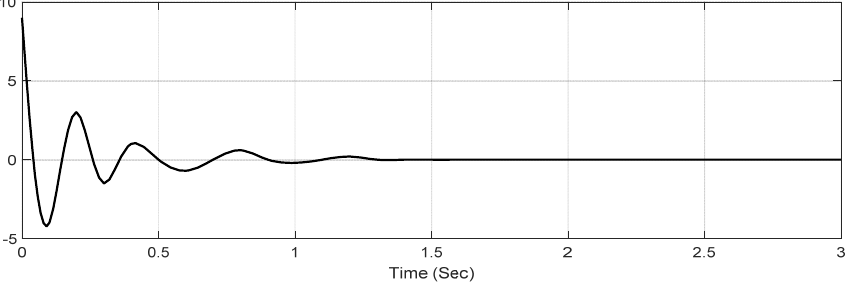
Figure 9. The control signal.